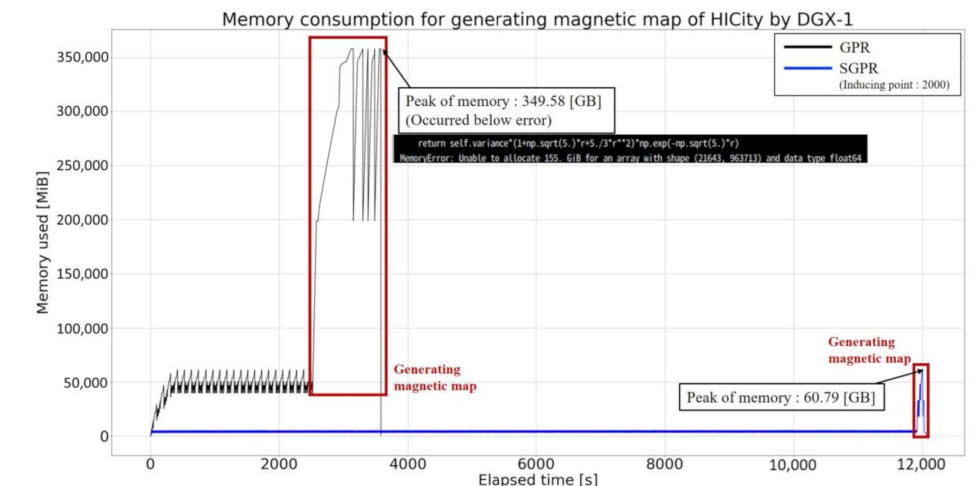
Figure 9. Graph of memory consumption for magnetic mapping of HICity using DGX-1.